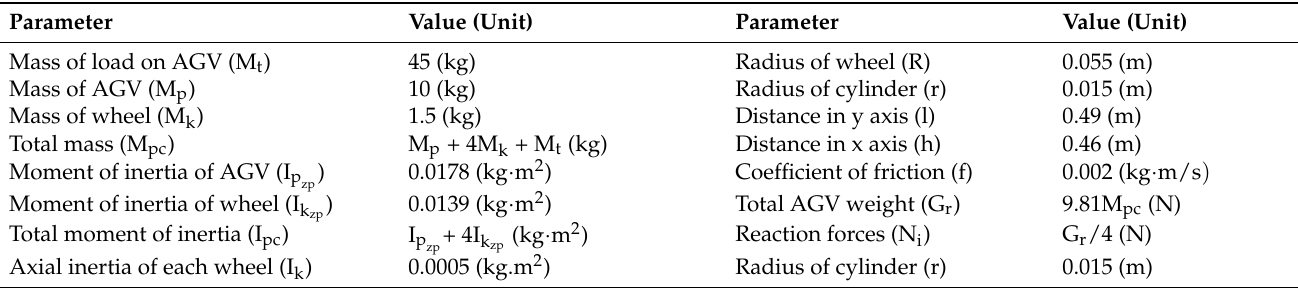
Table 1. The values of the AGV’s parameters.